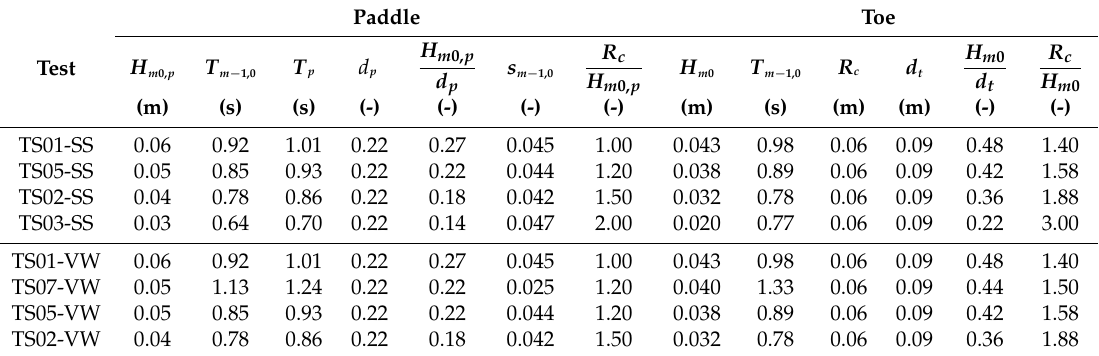
Table 1. Incident wave conditions for the JONSWAP spectra random wave laboratory tests. Paddle Test